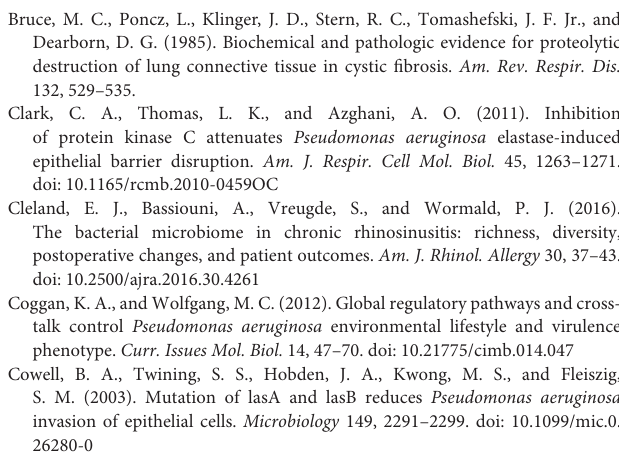
Supplementary Figure 3 | Growth curves and elastase activity of 18 P. aeruginosa CRS clinical isolates. Cell number was estimated by measuring